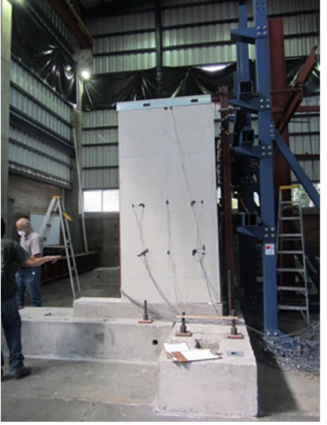
Figure 25. Diagram of the deformation experimented by the